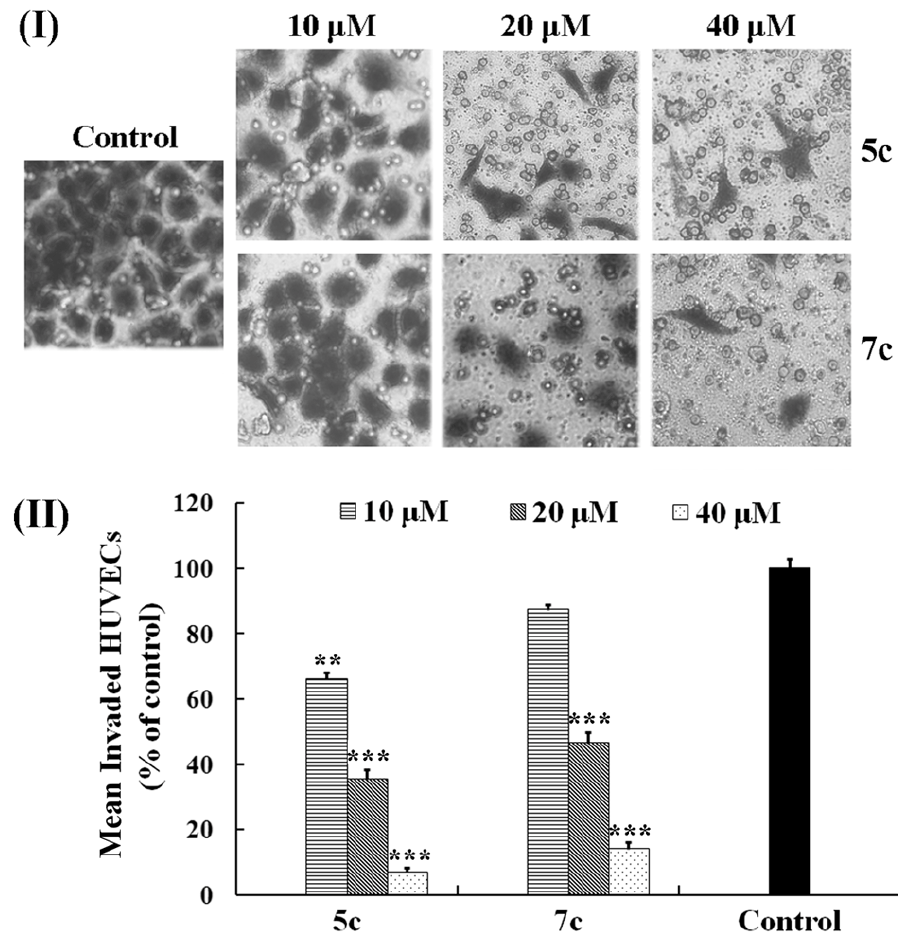
Figure 1. Effects of 5c and 7c on the HUVECs migration. ( I ) HUVECs seeded in 24-well Chambers were incubated for 6 h with medium alone (control) or contained the indicated concentration (10, 20, and 40 μ M) of 5c and 7c . The photographs exhibited the migrated cells on the lower surface of the filter stained with 1% crystal violet under a phase contrast microscopy (magnification: 200×). ( II ) Mean invaded HUVECs (% of control) were quantitatively analyzed by the inhibitory effects of 5c and 7c . Data represented the mean ± standard error (SE) from three independent